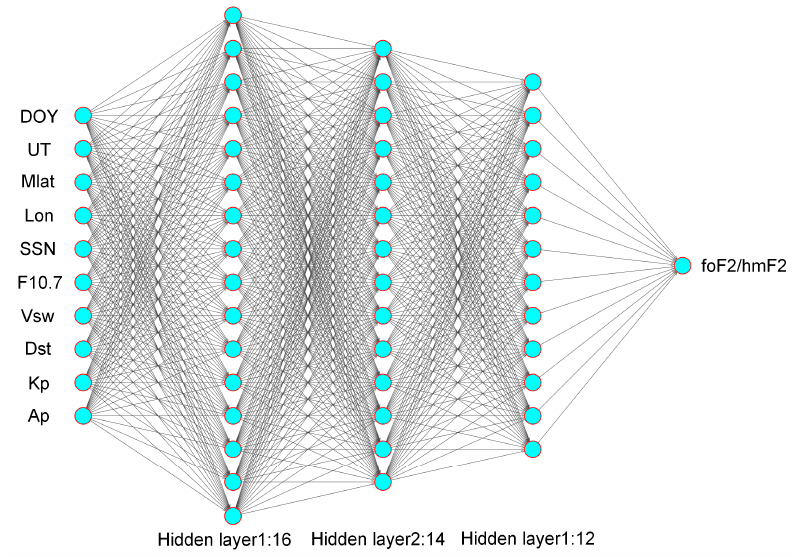
Figure 2. Schematic structure of the artificial neural network